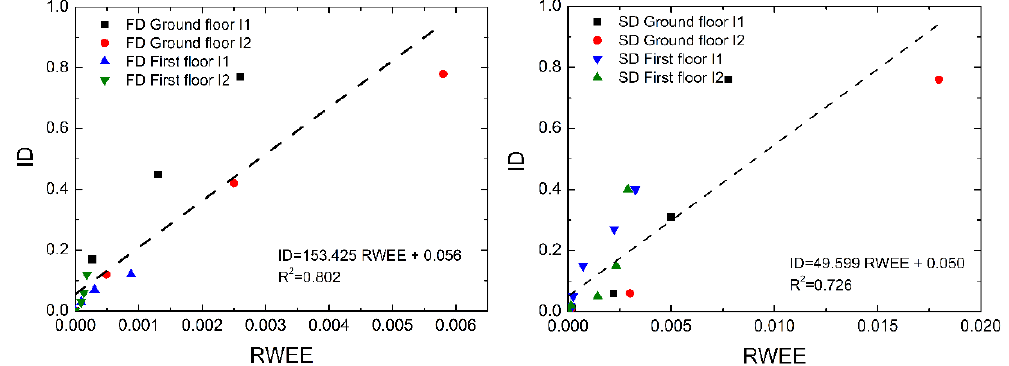
Figure 11. RWEE vs. ID for dampers of specimens FD and SD.